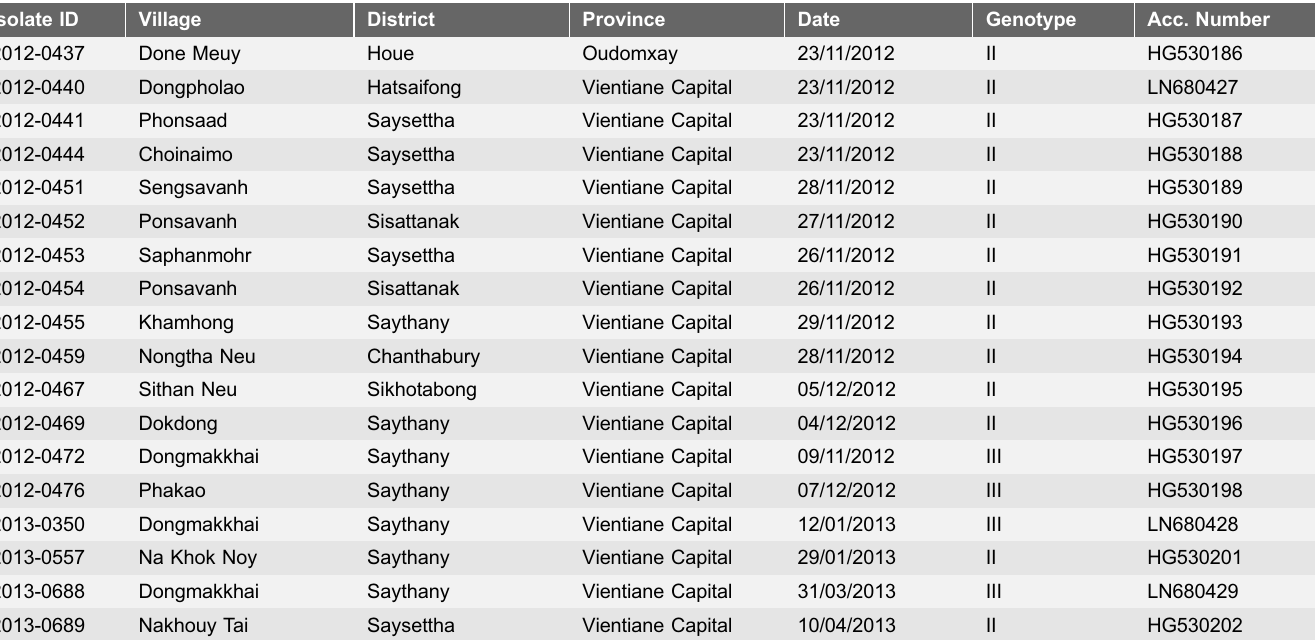
Envelope gene sequencing Sequencing of the complete envelope (E) gene (1479 nt) was performed on sixty- two Lao isolates of DENV-3 (Table 1). Amplicons were generated using the Superscript One Step kit (Invitrogen). The one-step RT-PCR reaction was performed in a volume of 25 m L containing 2 m L RNA template, 7 m L ddH2O, 12.5 m L RT-PCR buffer (5X), 1 m L sense oligonucleotide (10 m M), 1 m L anti-sense oligonucleotide (10 m M), 0.5 m L DMSO and 1 m L enzyme mix. The following set of specific primers was used to produce 3 overlapping amplicons: Den3-1F 5 9 -